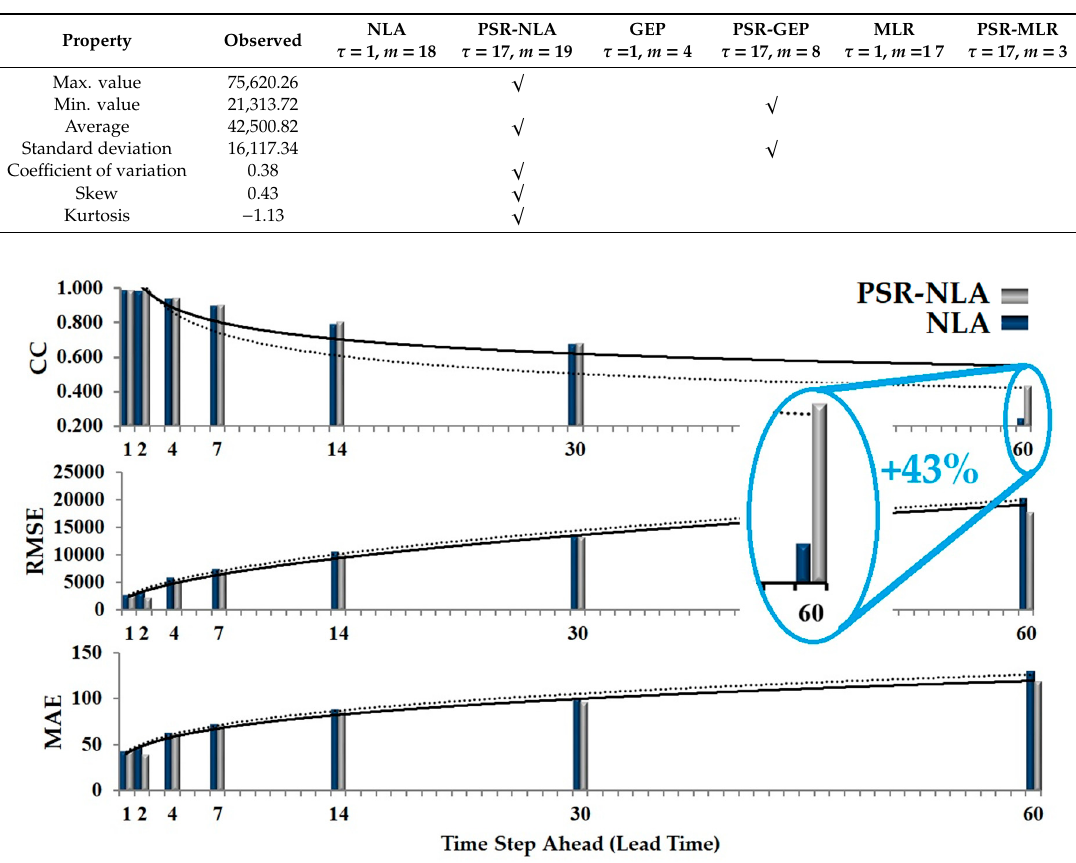
Table 6. Statistics comparison of observed and forecasted consumption in test period by the selected models.